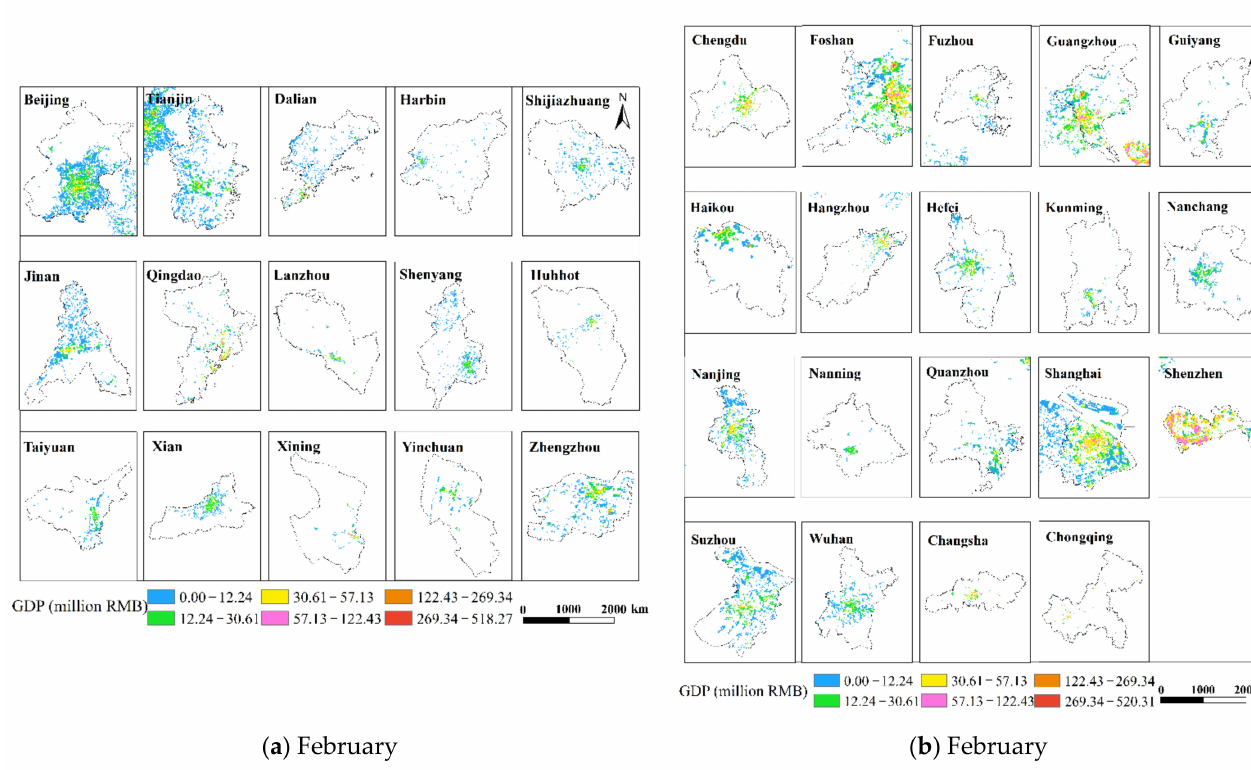
Figure 6. The spatialization of GDP of 34 cities in the secondary industry from February to April 2020.